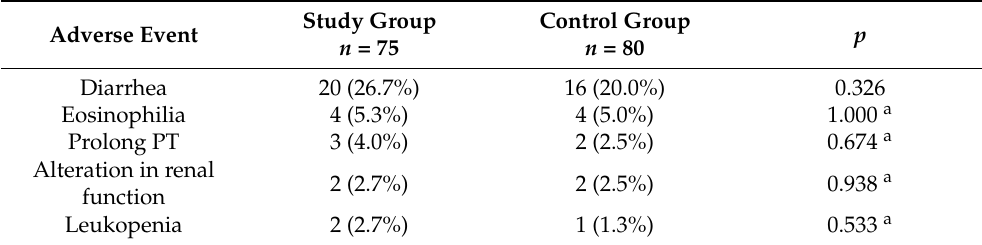
Table 5. Overall summary of adverse